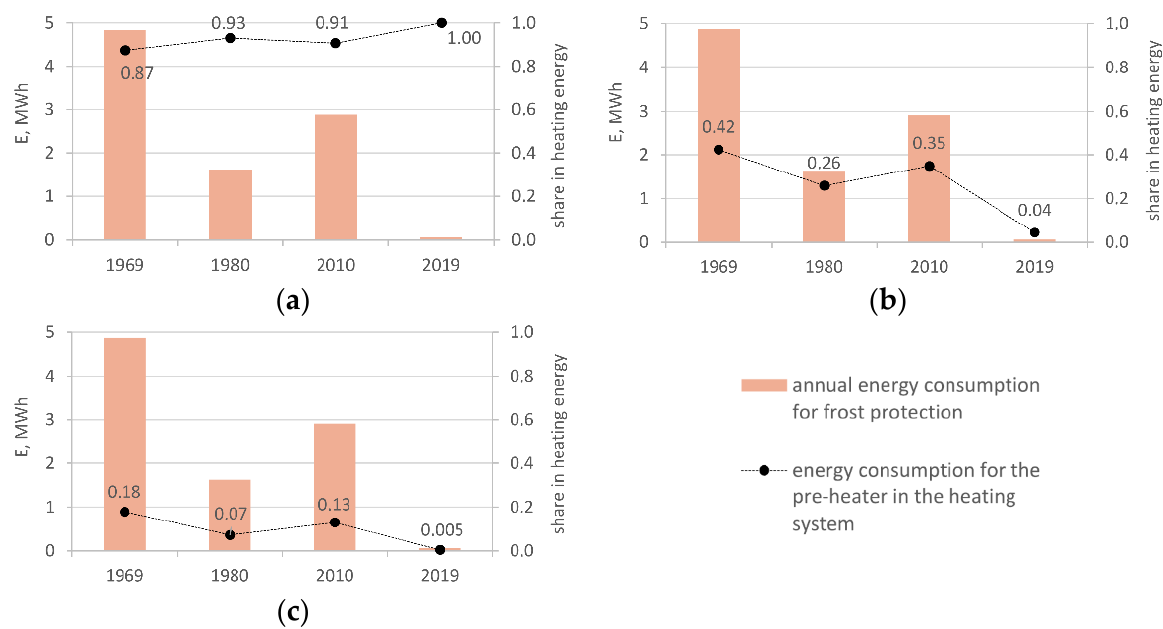
Figure 15. Energy demand for freeze protection system and share in heating energy: ( a ) t sup 2 = 12 °C, ( b ) t sup 1 = 15 °C, ( c ) t sup 3 = 18 °C.